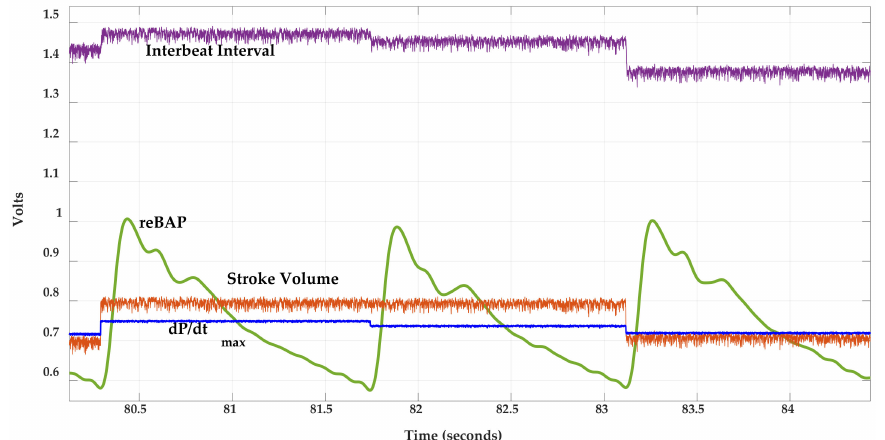
Figure 8. Representative signals collected from the Finapres Finometer PRO ® . As in Figure 7, the reBAP signal is scaled at 100 mmHg/volt. The interbeat interval, stroke volume, and dP/dt max are scaled at 1000 ms/volt, 100 mL/volt, and 1 mmHg/s/volt,